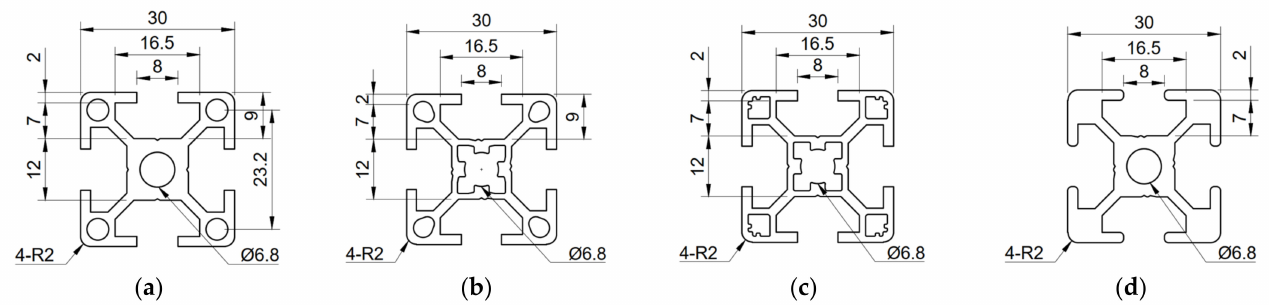
Figure 2. Geometrical Model of Aluminum Frame Extrusions: ( a ) Standard; ( b ) Economy; ( c ) Lightweight; ( d )